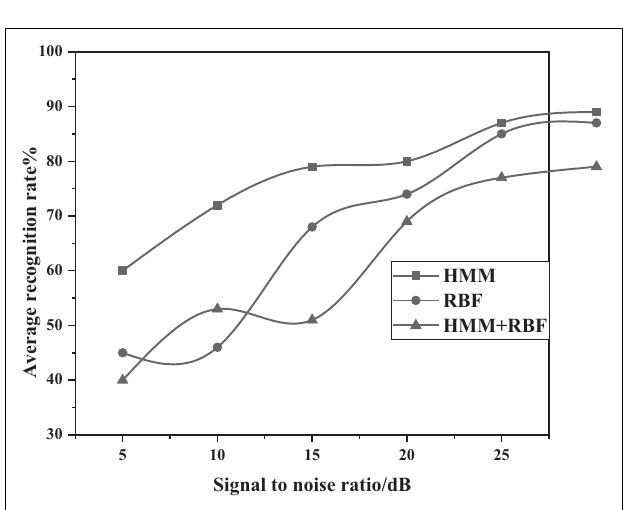
FIGURE 11 | Average recognition rate of three algorithms under different signal-to-noise ratios.